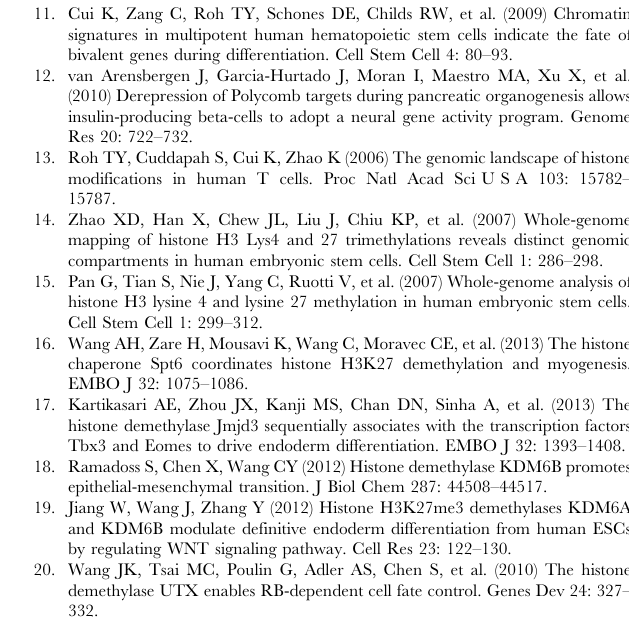
Hoxc (B), and Hoxd (C), clusters. Illustrated are Input (black), (blue), KO RA H3K4me3 ChIP (orange), and MACS defined enrichment peaks are illustrated as black bars underneath each track. Figure S7 Analysis of MLL and PCR2 complexes in Utx and Jmjd3 mutant cells. (A) Western blot analyzing levels of MLL complex members ASH2L and RBBP5 in Utx fl/fl ; Jmjd3 fl/fl ; Cre ER ES cells 2 TX or + TX. (B) Western blot levels of PRC2 component EZH2 and RBBP5 in WT ES cells, 2 day RA differentiated ES cells, or 2 day differentiated EBs. (C) EZH2 ChIP-qPCR of Utx fl/fl ; Jmjd3 fl/fl ; Cre ER ES cells (dark green, Diff 2 ) or after 2 days of RA treatment (light green or red, Diff + ) left untreated (green) or pre-treated with tamoxifen (red). An IgG control ChIP is illustrated as white bars. Quantitative PCR of an EZH2 negative locus ( Npm1 , Neg ) was utilized for comparison to RARE , Hoxa1 , Hoxa2 , Hoxb1 , Hoxb2 , and Hoxd9 . Figure S8 Analysis of Utx and Jmjd3 mutant MEFs. (A) RT-PCR of Hoxa3 , Hoxc4 , Hoxa13 , or Hoxd13 in ES cells, retinoic acid treated ES cells, or MEFs. (B) Western blot of EZH2 relative to RBBP5 loading control from Utx + /y ; Jmjd3 + / D or Utx D /y ; Jmjd3 D / D MEFs. (C) Quantitation of western blots for EZH2 or H3K4me3 from Utx + /y ; Jmjd3 + / D (grey) or Utx D /y ; Jmjd3 D / D (black) MEFs. Significant increases in protein levels are indicated (*p-value=0.04). (TIF) Table S1 Promoters experiencing H3K27me3 loss in ES to RA differentiation. EdgeR statistical comparison for significant (FDR , 0.05) loss of H3K27me3 normalized sequence reads in WT RA relative to WT ES (sheet 1) and KO RA relative to KO ES (Sheet 2) across the TSS + / 2 1 KB. Some genes have multiple alternative promoters, so genes that are duplicated within the list